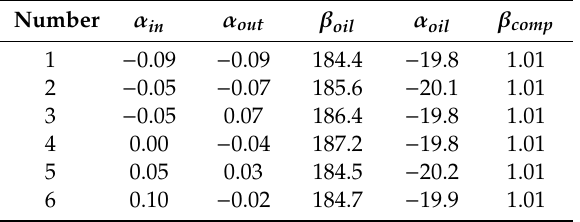
Table 13. The configuration of variables in verification experiment.